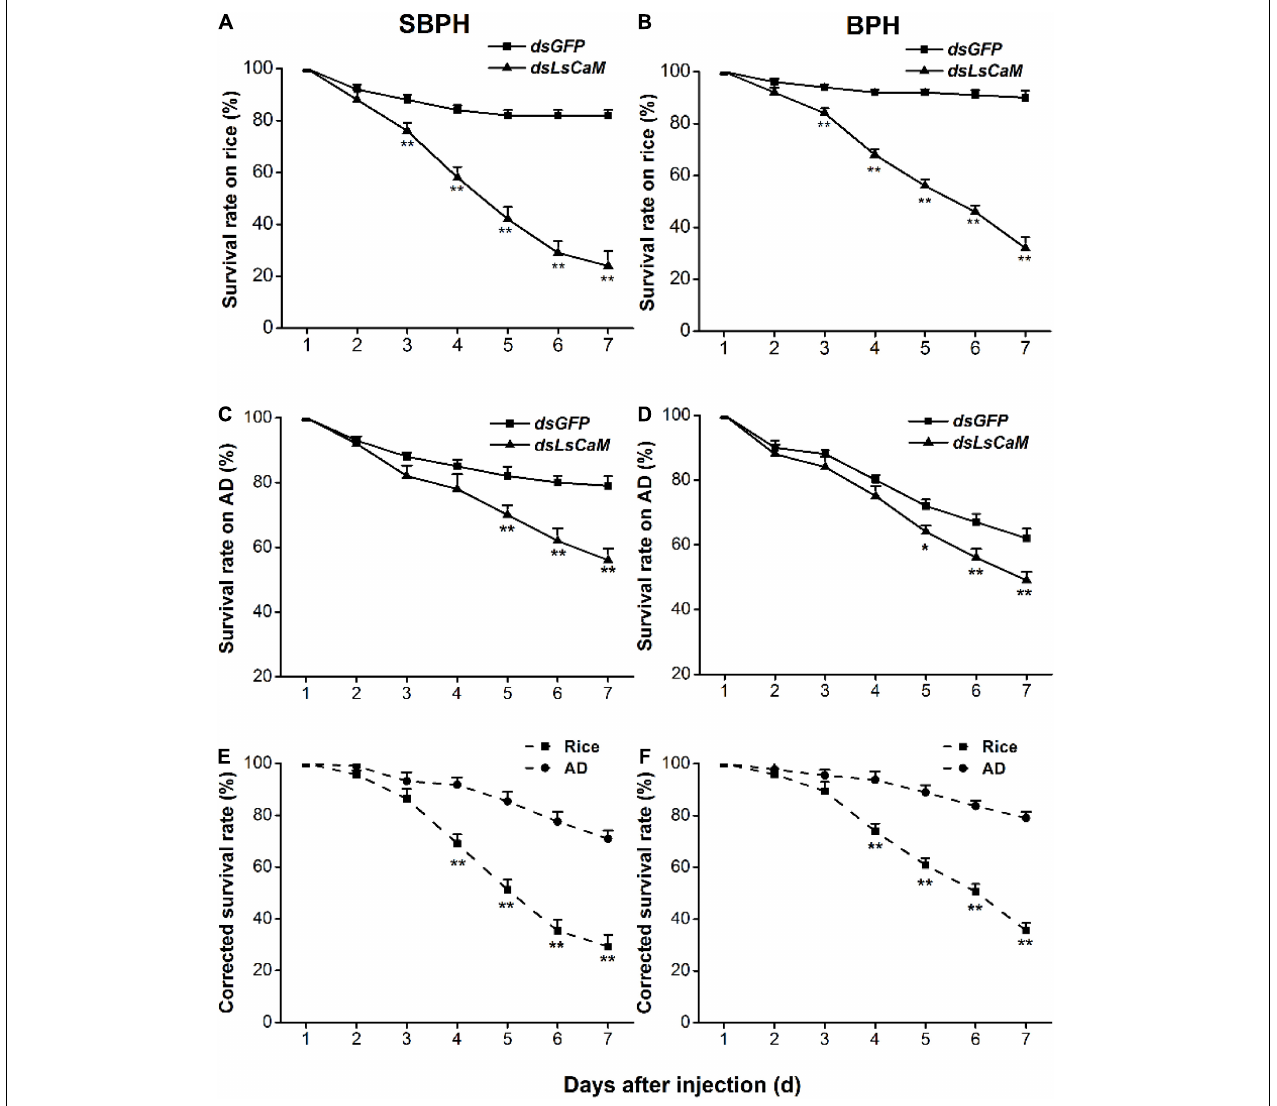
FIGURE 3 | Knocking down CaM reduces survival rates among nymphs. (A–D) Mean survival rates + SE ( n = 5) of SBPH and BPH nymphs injected with dsLsCaM or dsGFP at third-instar nymph stage, fed on rice (A,B) or artificial diet (AD; C,D ). (E,F) Mean corrected survival rates + SE ( n = 5) of SBPH (E) and BPH (F) nymphs with injected dsLsCaM , using nymphs with injected dsGFP as controls, feeding on rice plants or artificial diet. Asterisks indicate significant differences between treatments (* P < 0.05, ** P < 0.01; Student’s t